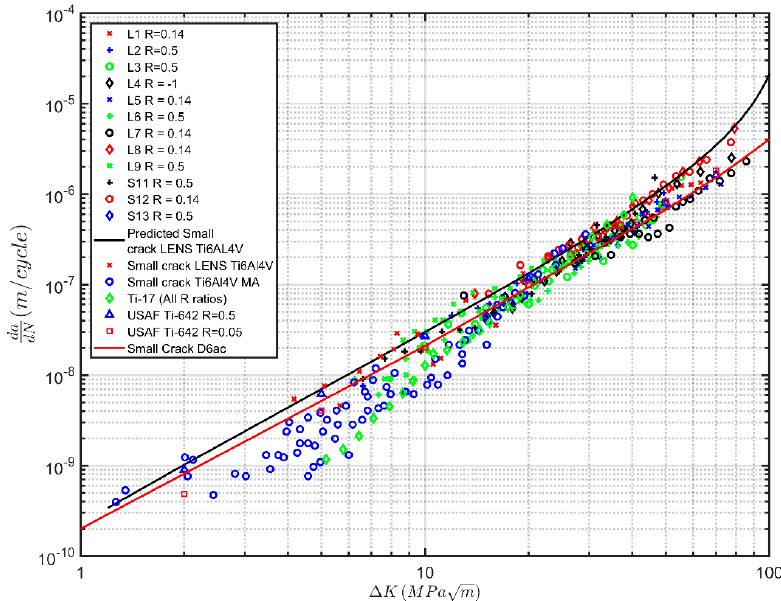
Figure 6. Comparison of small crack growth in LENS Ti-6Al-4V, Ti-6Al-4V MA, Ti-17, Ti-642, and a 350 MPa locomotive mild steel, which were tested at a range of R ratios, with the predicted small crack growth in small crack growth in LENS Ti-6Al-4V.